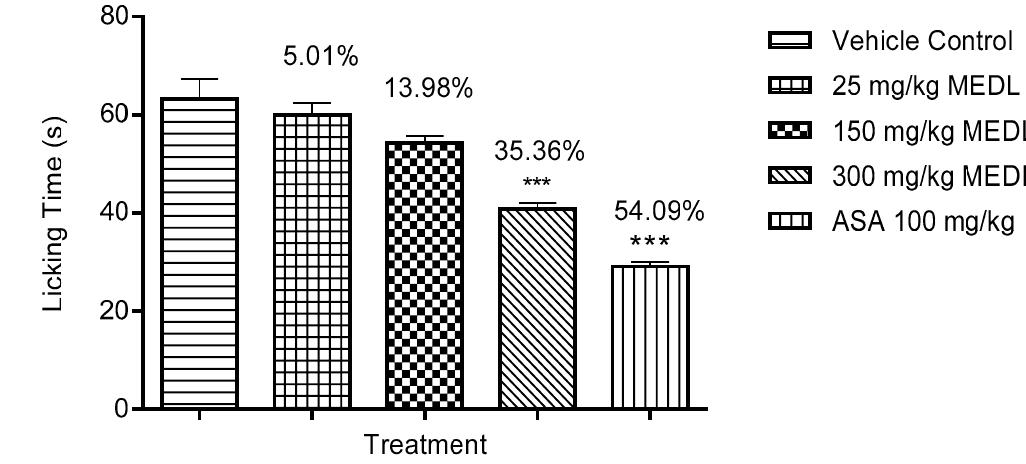
Figure 7. Effect of MEDL on PMA-induced nociception in mice. Each column represents the mean ± SEM of six mice. Statistical analyses were performed using 1–way ANOVA followed Tukey’s multiple comparisons test. *** p < 0.001 compared to vehicle control group. Values on top of columns denote inhibition.